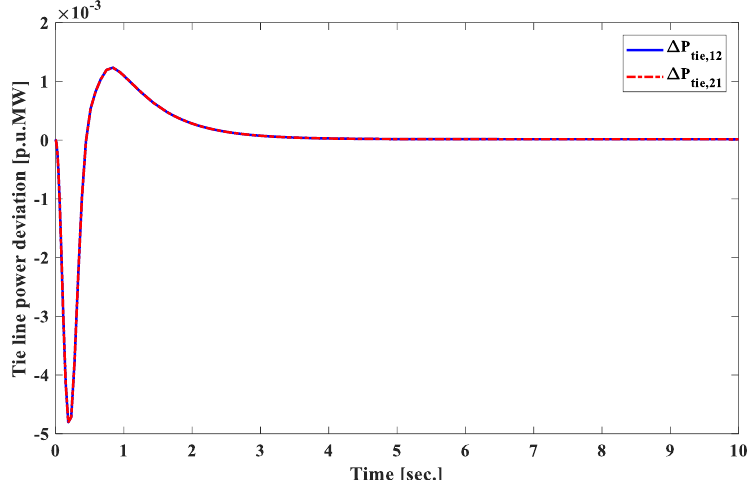
Figure 10. Tie-line power deviation [p.u.MW] of control areas 1 and 2 with matched disturbances.